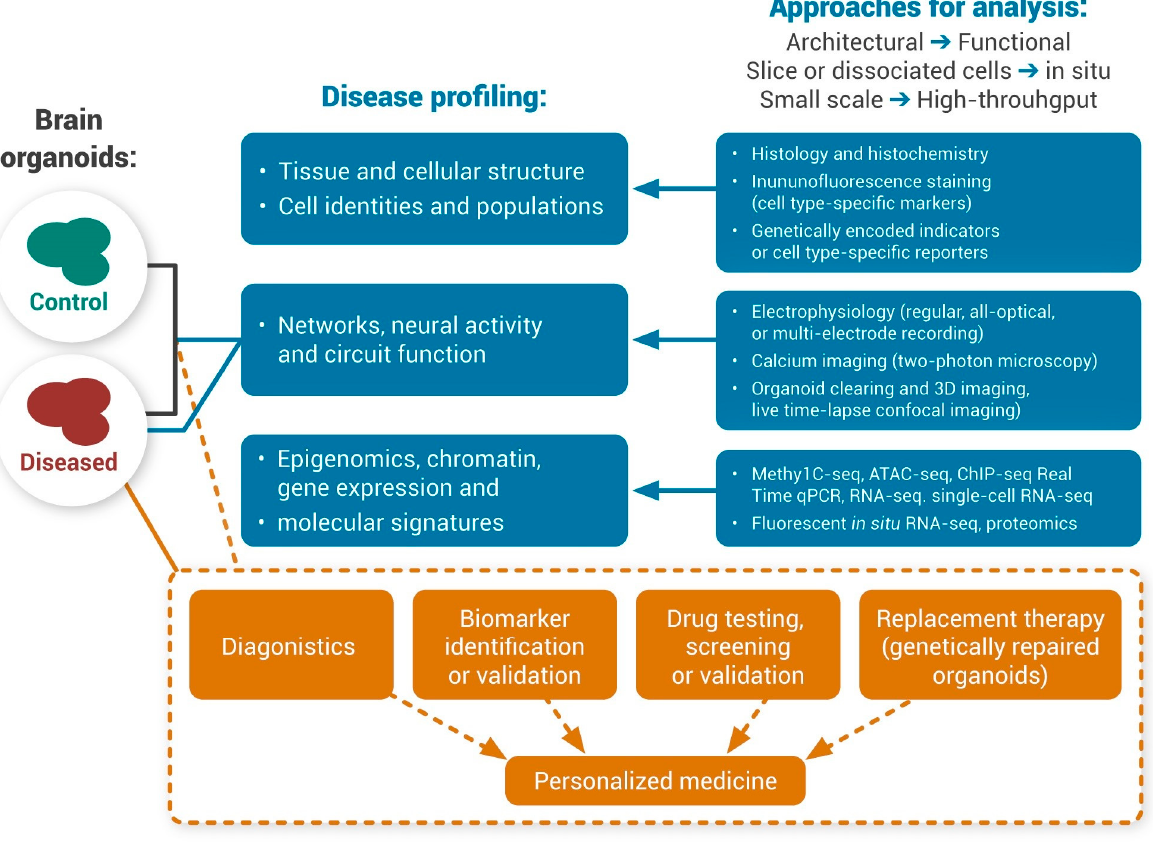
Figure 6. Proposed applications of human brain organoids in neurological diseases. Abbreviations: ATAC-seq, assay for transposase-accessible chromatin with high-throughput sequencing; ChIP-seq, chromatin immunoprecipitation, and sequencing; MethylC-seq, MethylC sequencing; qPCR, quantitative PCR; RNA-seq, RNA sequencing. This figure has been reproduced according to [125] under